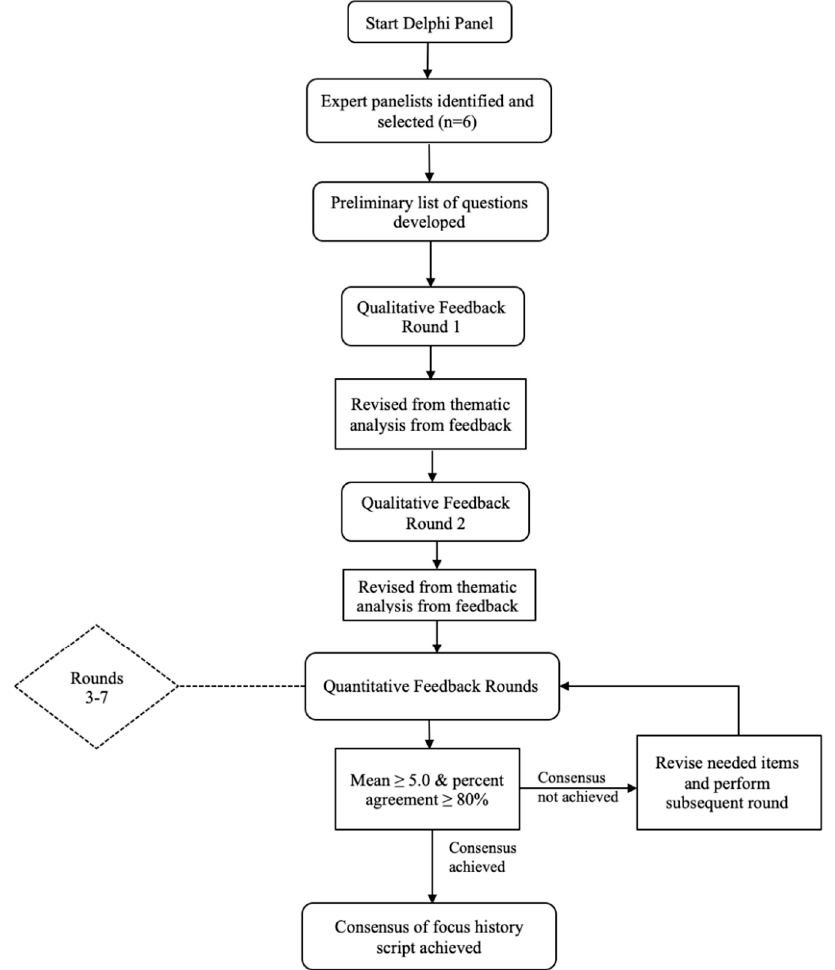
Figure 1. Delphi Panel